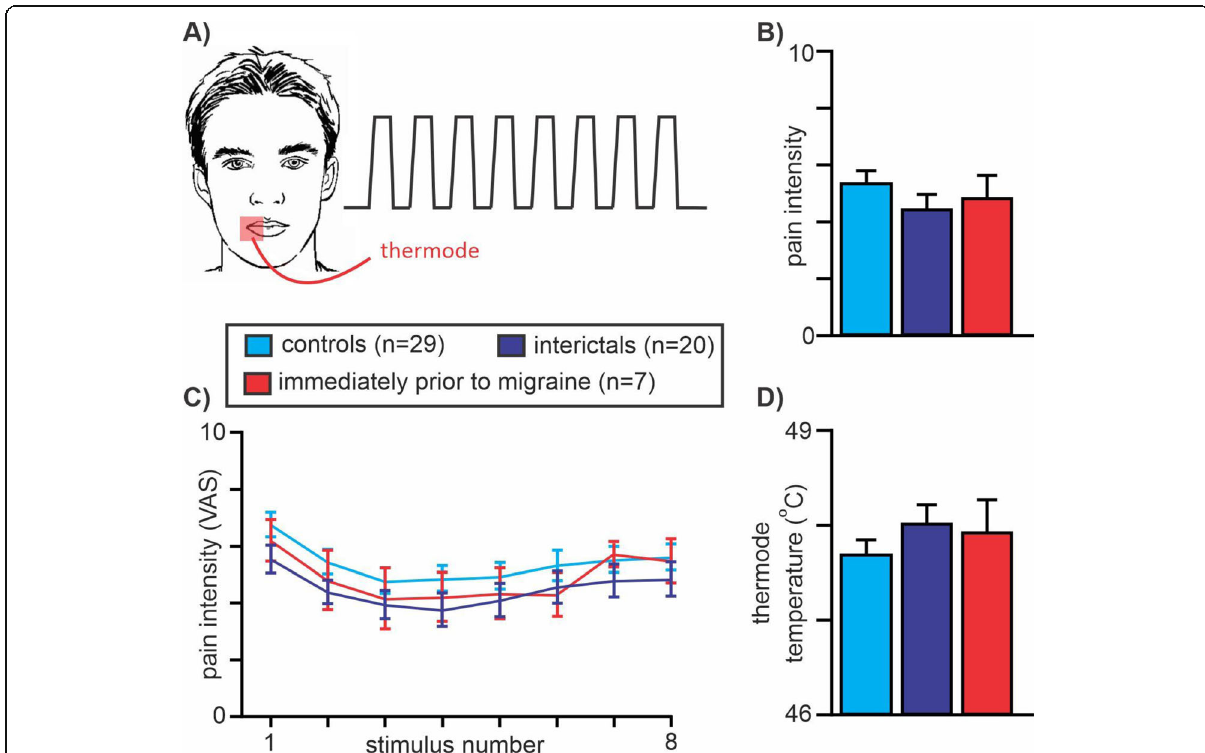
Fig. 2 A Eight acute noxious thermal stimuli were delivered to the corner of the mouth in controls, migraineurs during the interictal phase and in migraineurs in the 24 h immediately prior to a migraine headache; ( B) Mean ± SEM pain intensity ratings over the 8 noxious stimuli for each group; (C) Mean ± SEM pain intensity ratings for each of the 8 noxious stimuli in each group; (D) Mean ± SEM administered thermode temperatures for each of the three groups. Note there were no significant differences in pain intensity rating or thermode temperatures between any of the